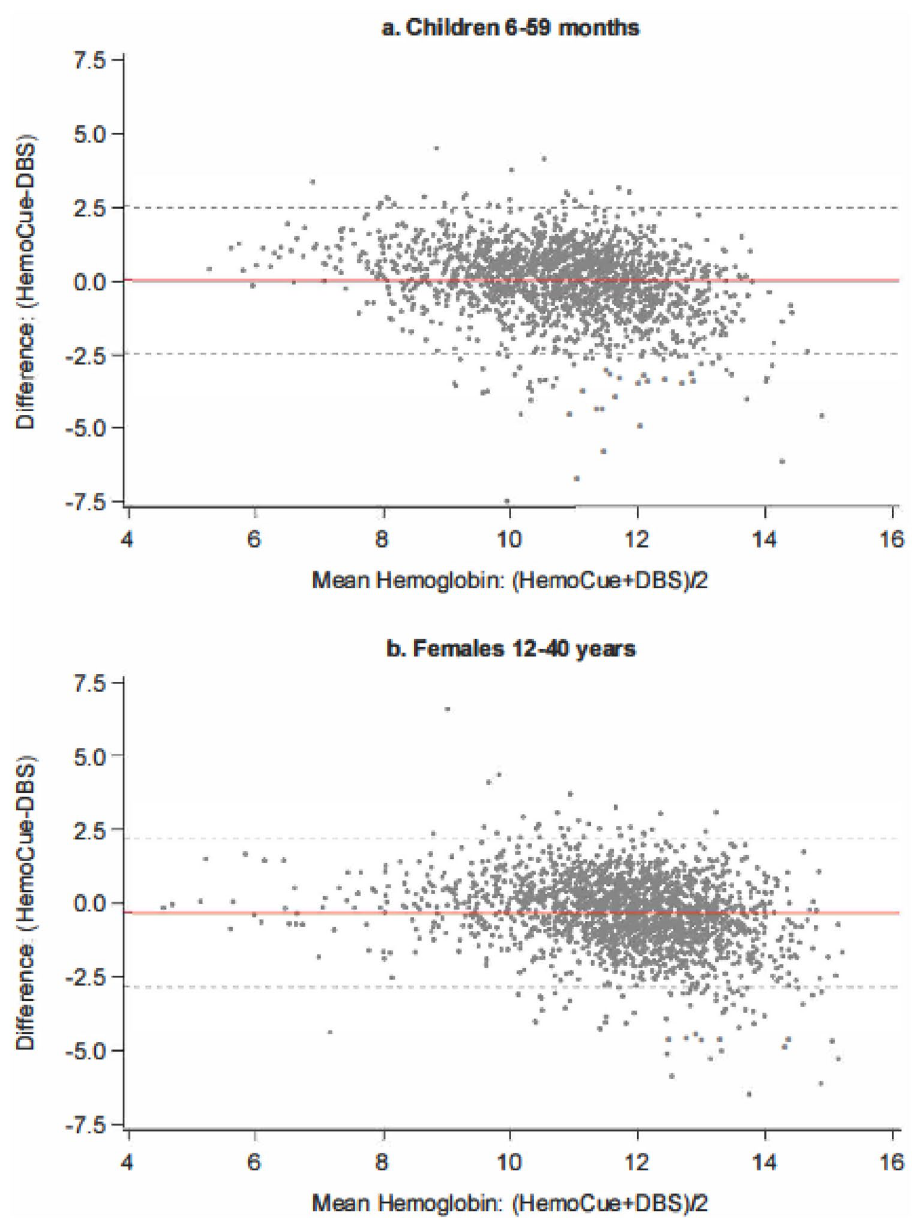
Figure 2. Bland–Altman plot of HemoCue and DBS Hb measures, children 6–59 months ( a ) and females 12–40 years ( b ). The red line represents the mean difference; the dashed grey lines represent ± 1.96 SD of the mean difference indicating the statistical limits.